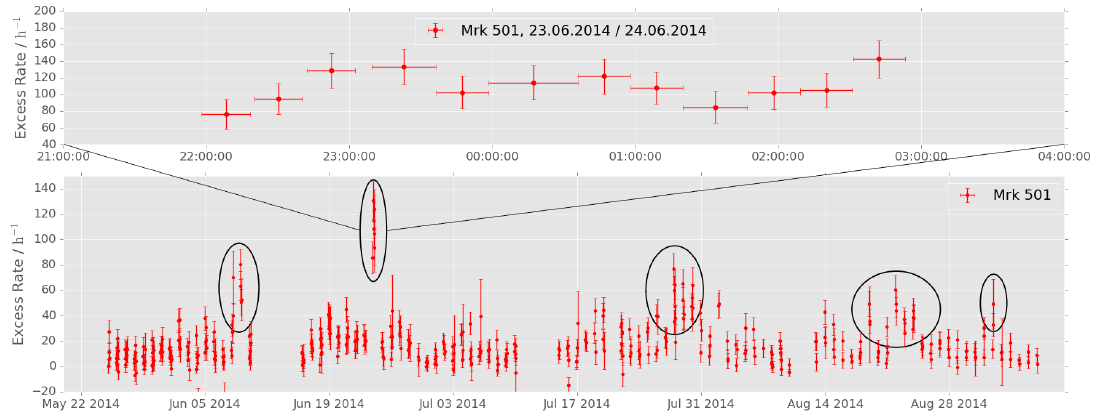
Figure 7. Excess rate curve for Markarian 501 in summer 2014. The highest flare is shown in more detail. Flaring states are marked with black ellipses. The bins correspond to observation windows with an effective ontime of 20 min (top) and 60 min (bottom). The effective ontime is the observation time with enabled